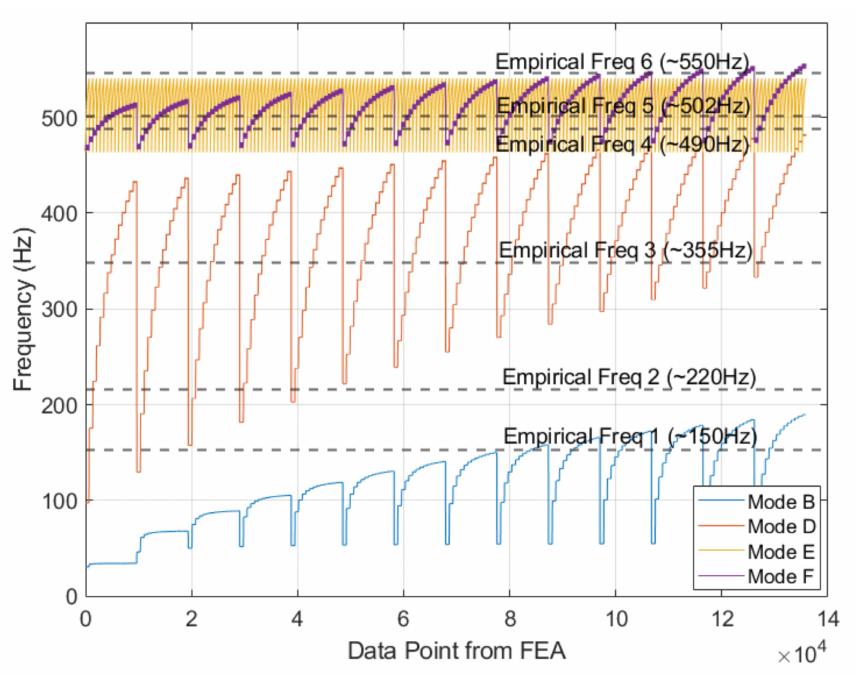
Figure 12. Day 1 Accelerometer Data vs. FEA. Note that 6 frequencies were extracted which are represented by the horizontal lines. The step-wise trend is caused by shift in boundary conditions. This is particularly noticeable on Mode D and parts of Mode B.